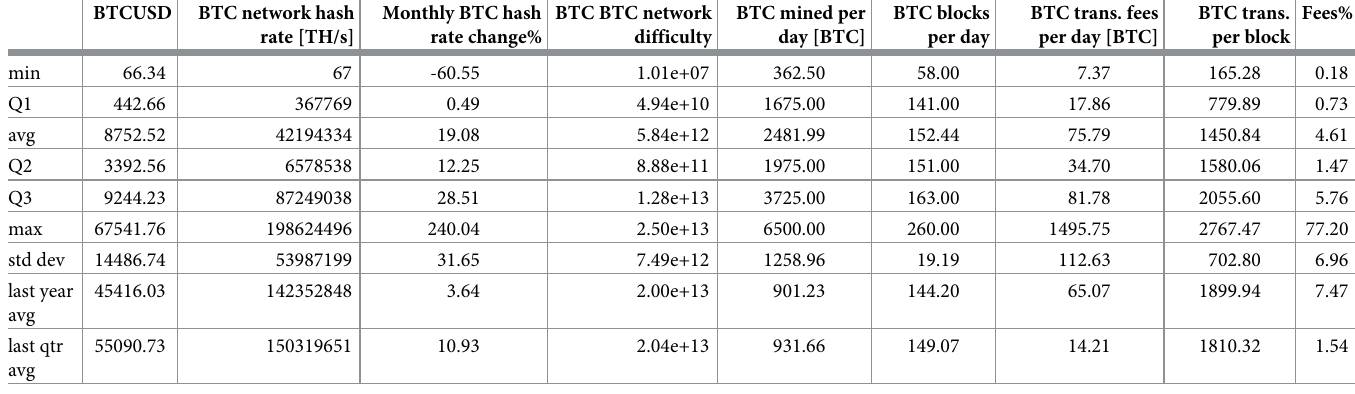
Note: The time period for this data is between 2013/05/01 and